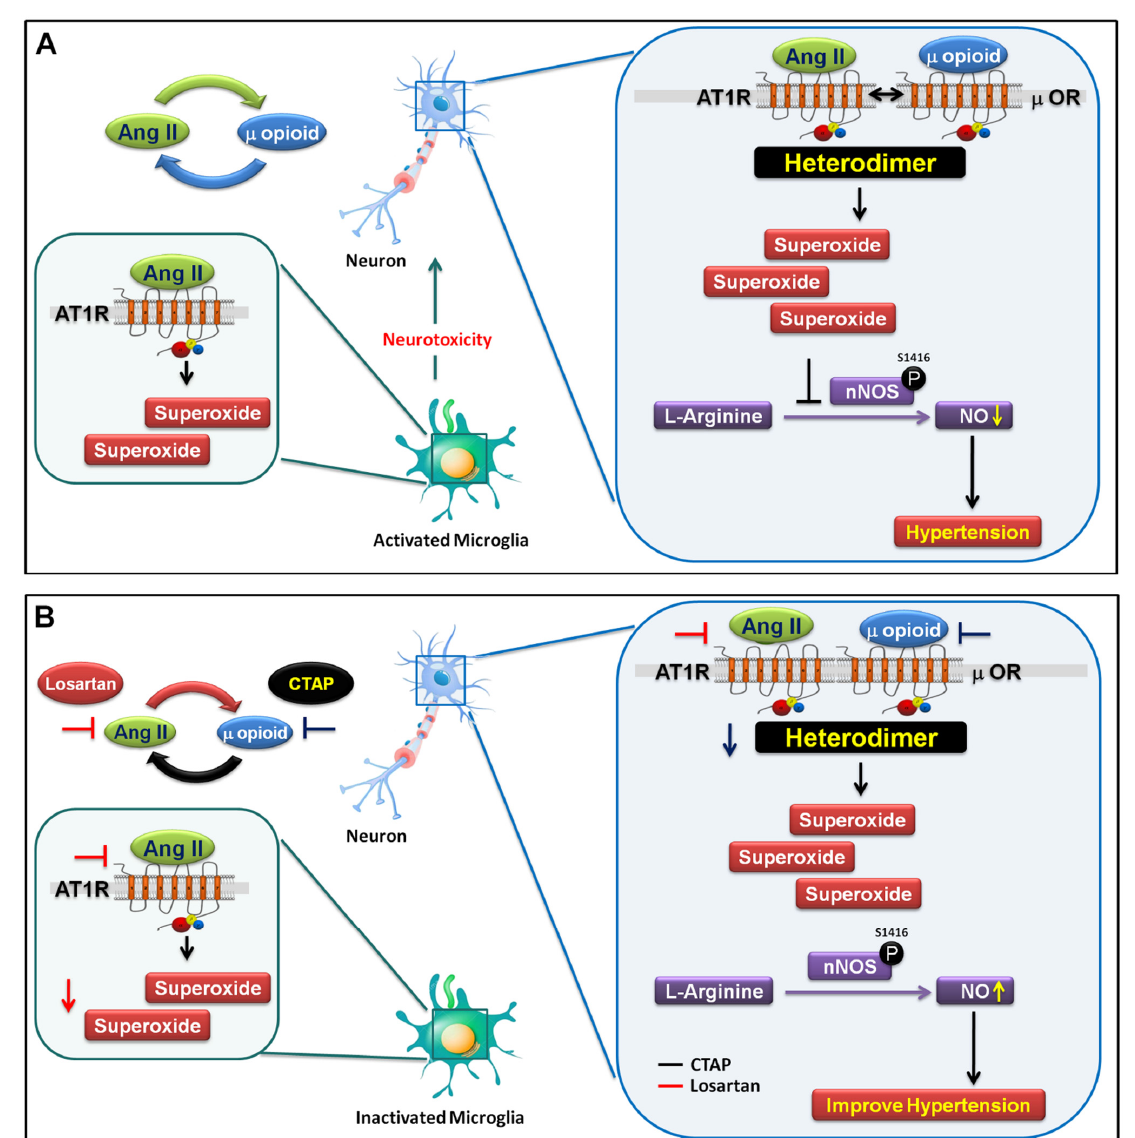
Figure 5. Proposed pathogenic mechanism for neurogenic hypertension . ( A ) The interaction of Ang II and μ OR enhances the binding of Ang II to the AT1R receptor, activates the microglia and promotes the formation of AT1R- μ OR heterodimers in the NTS, leading to superoxide production. This inactivates nNOS-derived NO, causing systemic elevations in blood pressure. ( B ) AT1R inhibitors (such as losartan) decrease superoxide production, abolish the activation of microglia and AT1R, and decrease TLR4 expression, which ultimately leads to improved hypertension (red line). Interestingly, μ OR inhibitors (such as CTAP) decrease BP and abolish μ OR-induced formation of AT1R and μ OR heterodimers. CTAP also significantly inactivates the activation of microglia and AT1R, and reduces TLR4 expression, which can lead to an increase nNOS-derived NO levels, thereby improving hypertension (black line). In summary, this study shows how the interaction between Ang II and μ OR enhances the binding of Ang II to AT1R, thereby causing microglia activation and inducing superoxide production, which, in turn, leads to neurotoxicity. Furthermore, the interaction of Ang II and μ OR also en- hances the formation of the AT1R and μ OR heterodimers and inactivates nNOS-derived NO, leading to the development of progressive hypertension.